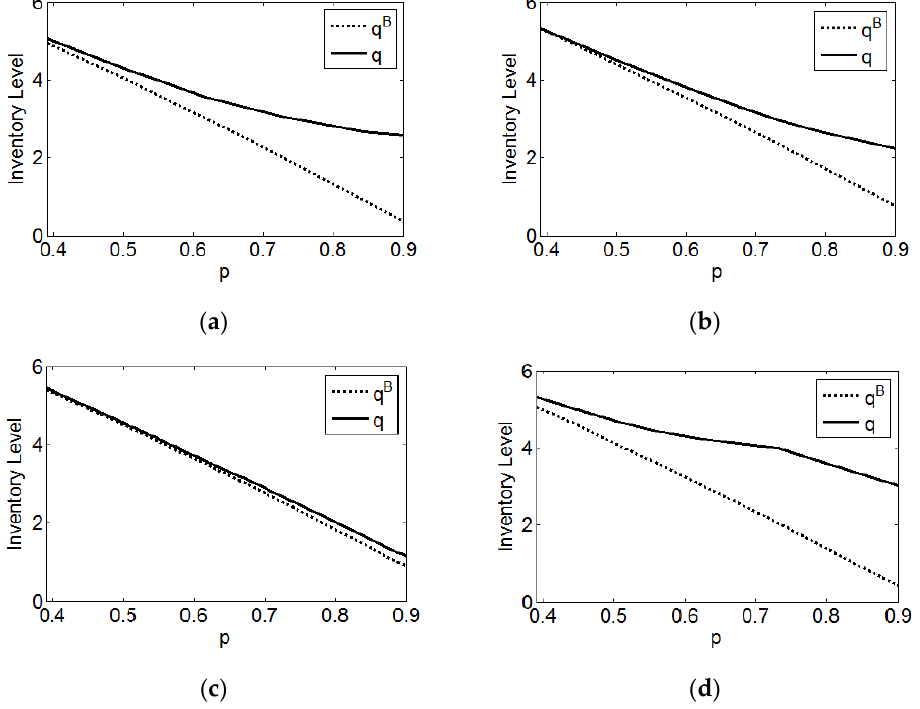
Figure 10. Impacts of p , δ , λ and r on store inventory level. ( a ) δ = 0.72, λ = 0.8, r = 0.2; ( b ) δ = 0.9, λ = 0.8, r = 0.2; ( c ) δ = 0.72, λ = 0.98, r = 0.2; ( d ) δ = 0.72, λ = 0.8, r =